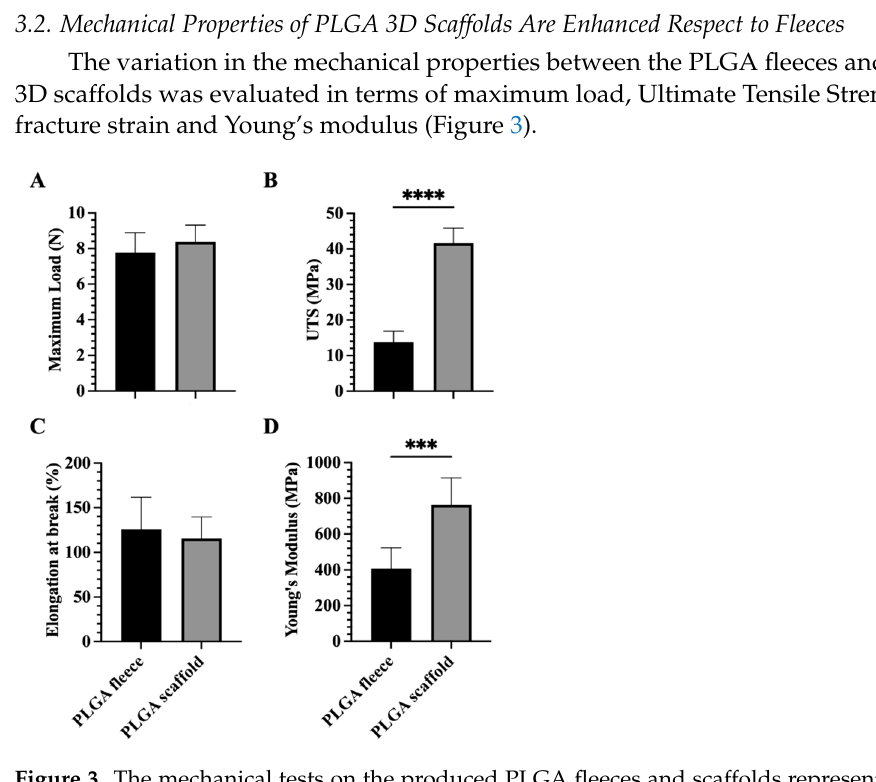
Figure 3. The mechanical tests on the produced PLGA fleeces and scaffolds represented in terms of ( A ) maximum load, ( B ) ultimate tensile strength (UTS), ( C ) elongation at break, and ( D ) Young’s Modulus. *** and **** Statistically significant between different groups ( p < 0.001 and p < 0.0001, respectively).